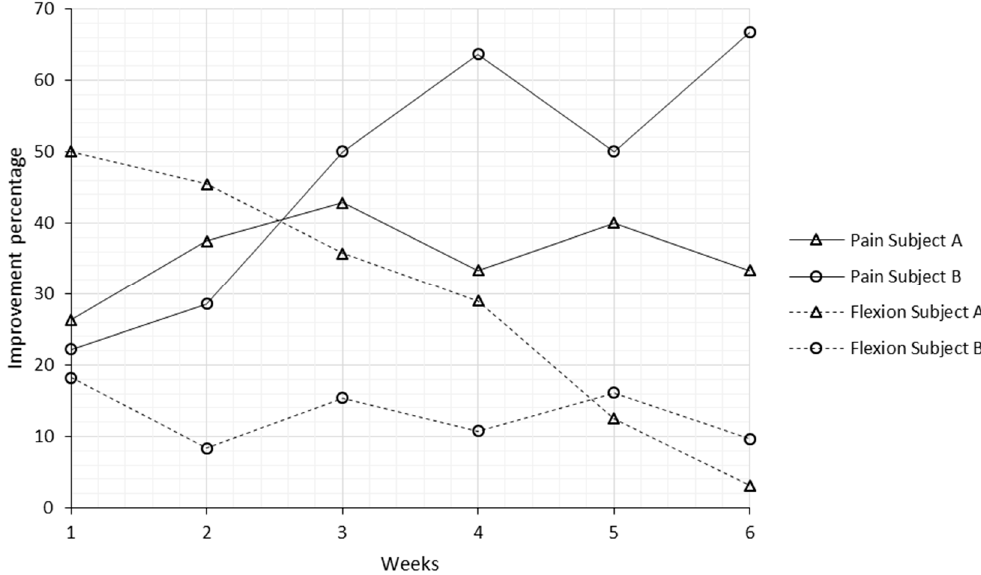
Figure 3. Improvement percentages for pain and knee joint flexion amplitude per session, considering each session initial and final scores, along the experimental